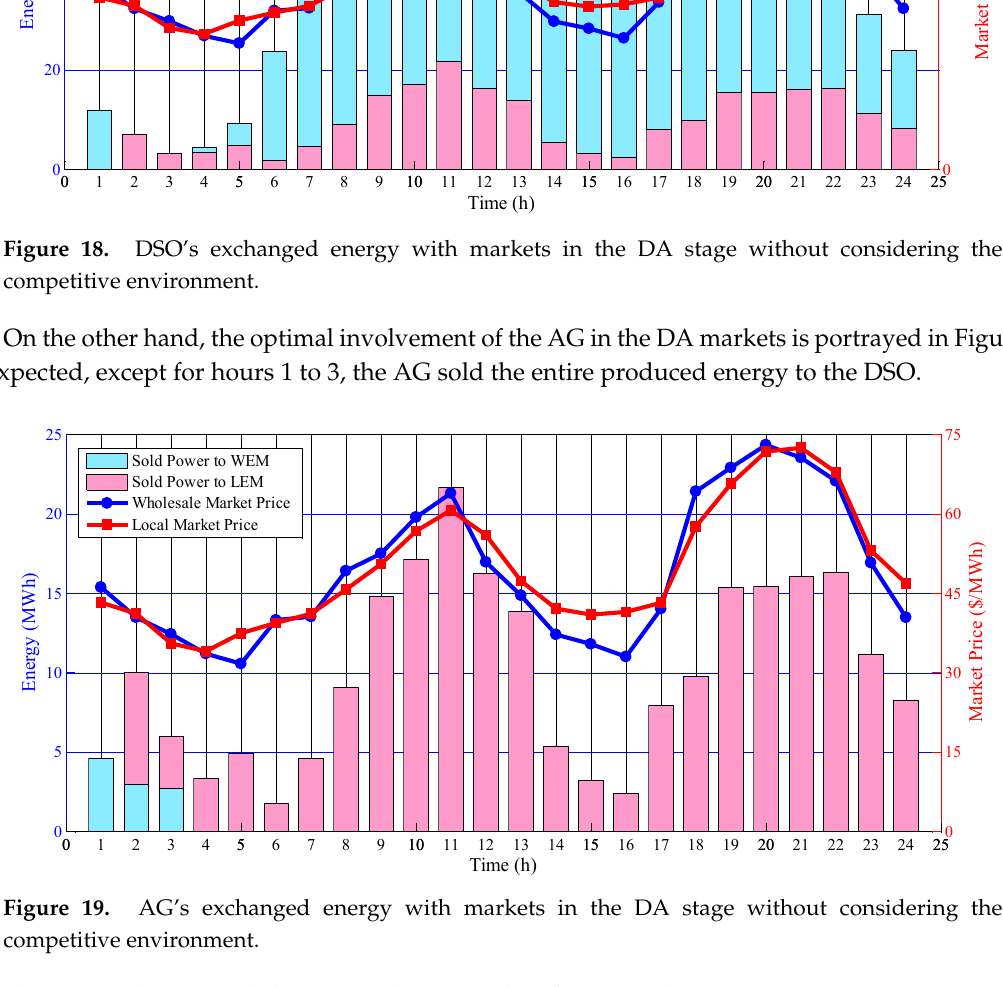
Figure 20. DSO’s traded energy in the RT markets for scenario 6 without considering the competitive environment.